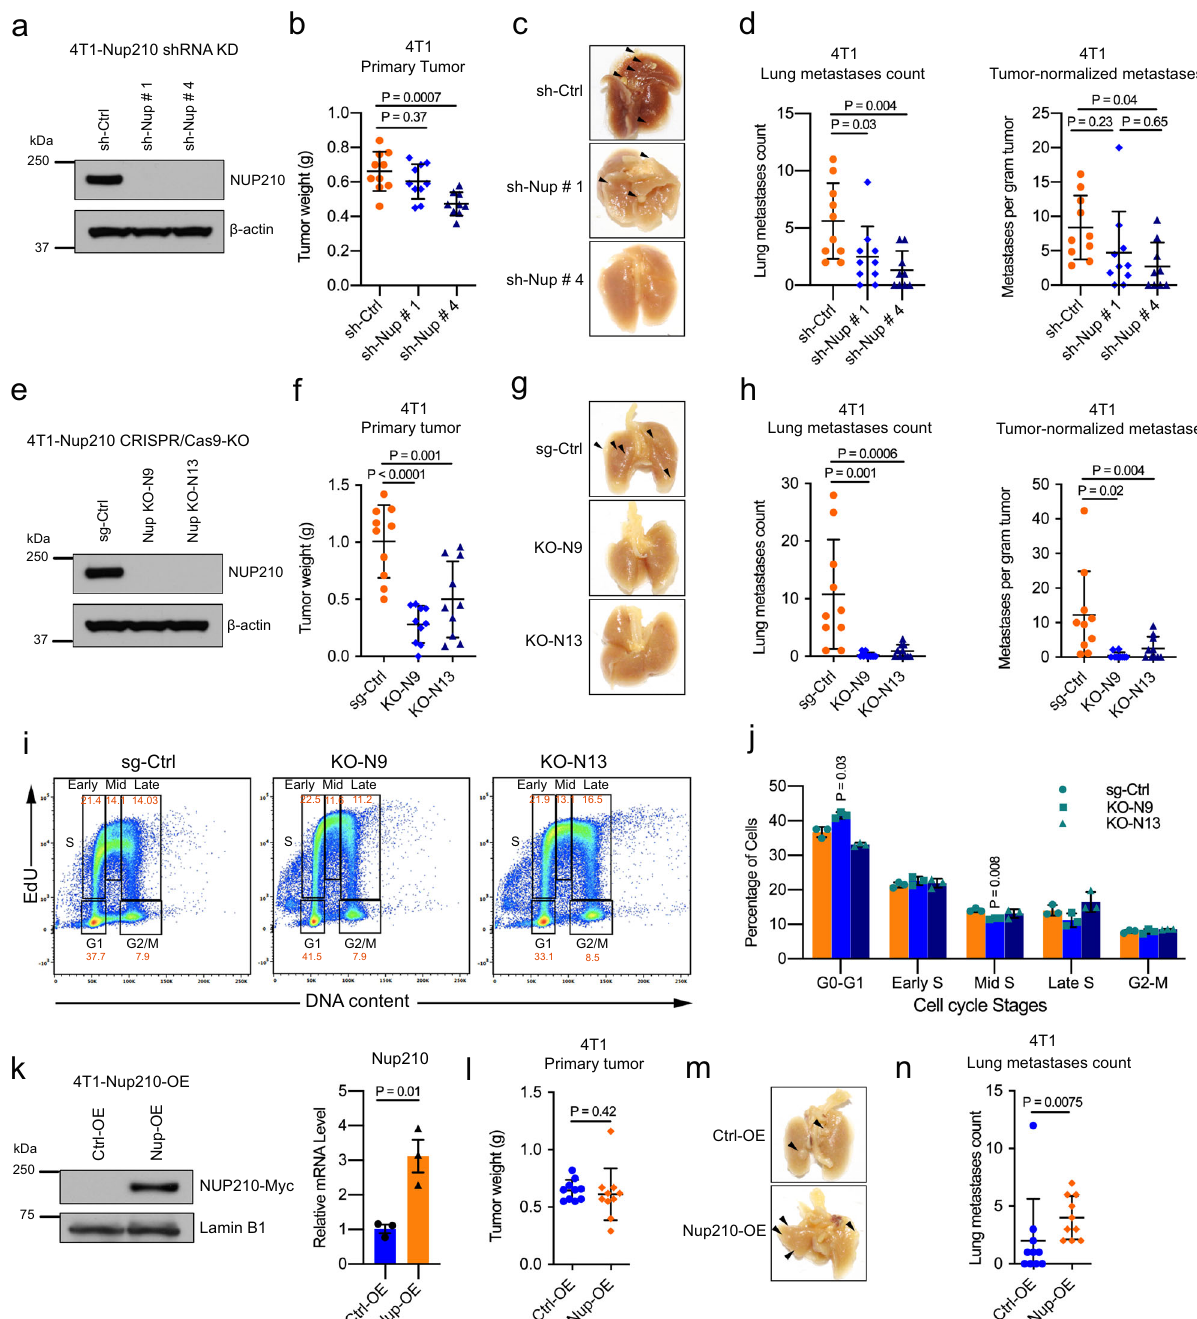
Fig. 3 Depletion of Nup210 in 4T1 metastatic cancer cells reduces lung metastasis in mice. a Western blot of Nup210 knockdown (KD) in 4T1 cells. b Primary tumor weight, c representative lung images, and d lung metastases count and lung metastases count normalized to primary tumor weight in orthotopically transplanted Nup210 KD 4T1 cells. ANOVA with Tukey ’ s multiple comparison test, mean ± s.d. sh-Ctrl, n = 10; sh # 1, n = 10; sh # 4, n = 9 mice. e Western blot showing CRISPR/Cas9-mediated knockout (KO) of Nup210 in 4T1 cells. f Primary tumor weight, g representative lung images, h lung metastases count and tumor-normalized metastases count after orthotopic transplantation of Nup210 KO 4T1 cells. ANOVA with Tukey ’ s multiple comparison test, mean ± s.d. n = 10 mice per group. i DNA content analysis with EdU incorporation of the different stages of the cell cycle in sg-Ctrl and Nup210 KO 4T1 cells. j Quanti fi cation of cell cycle stage distribution in sg-Ctrl and Nup210 KO 4T1 cells.Two-tailed t test, mean ± s.e.m, n = 3 biological replicates. k Western blot (left) and qRT-PCR (right) of NUP210 overexpression in 4T1 cells. Two-tailed t test, mean ± s.e.m, n = 3 biological replicates. l Primary tumor weight, m representative lung images, and n lung metastases count after orthotopic transplantation of NUP210-overexpressing 4T1 cells. Mann – Whitney U test, mean ± s.d. n = 10 mice per